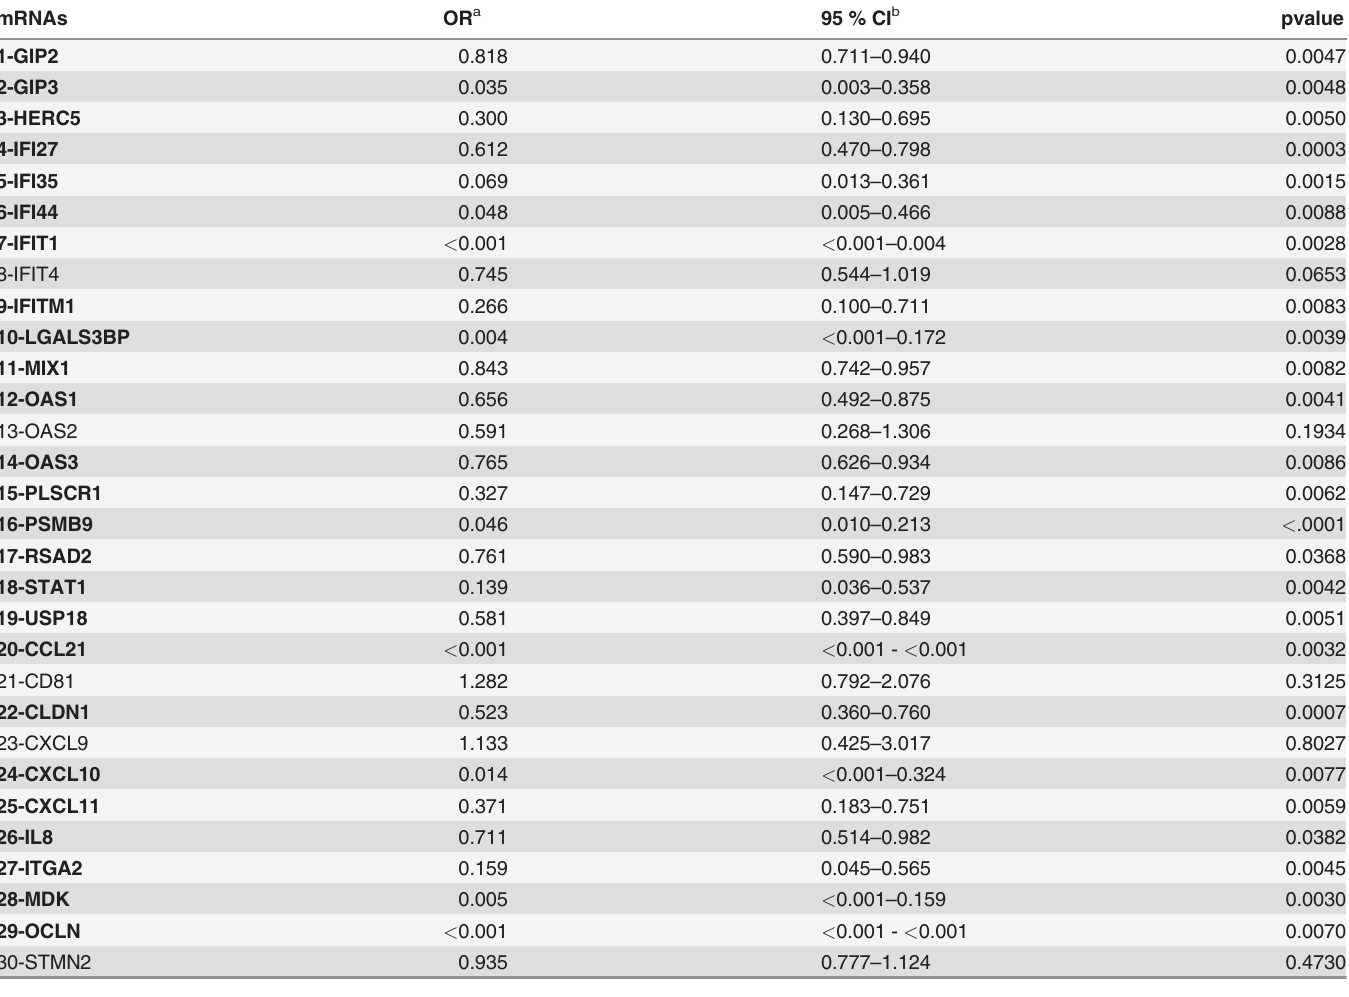
Table 4. Differentially expressed mRNAs between NRs and SVRs in patients with CHC prior to treatment.